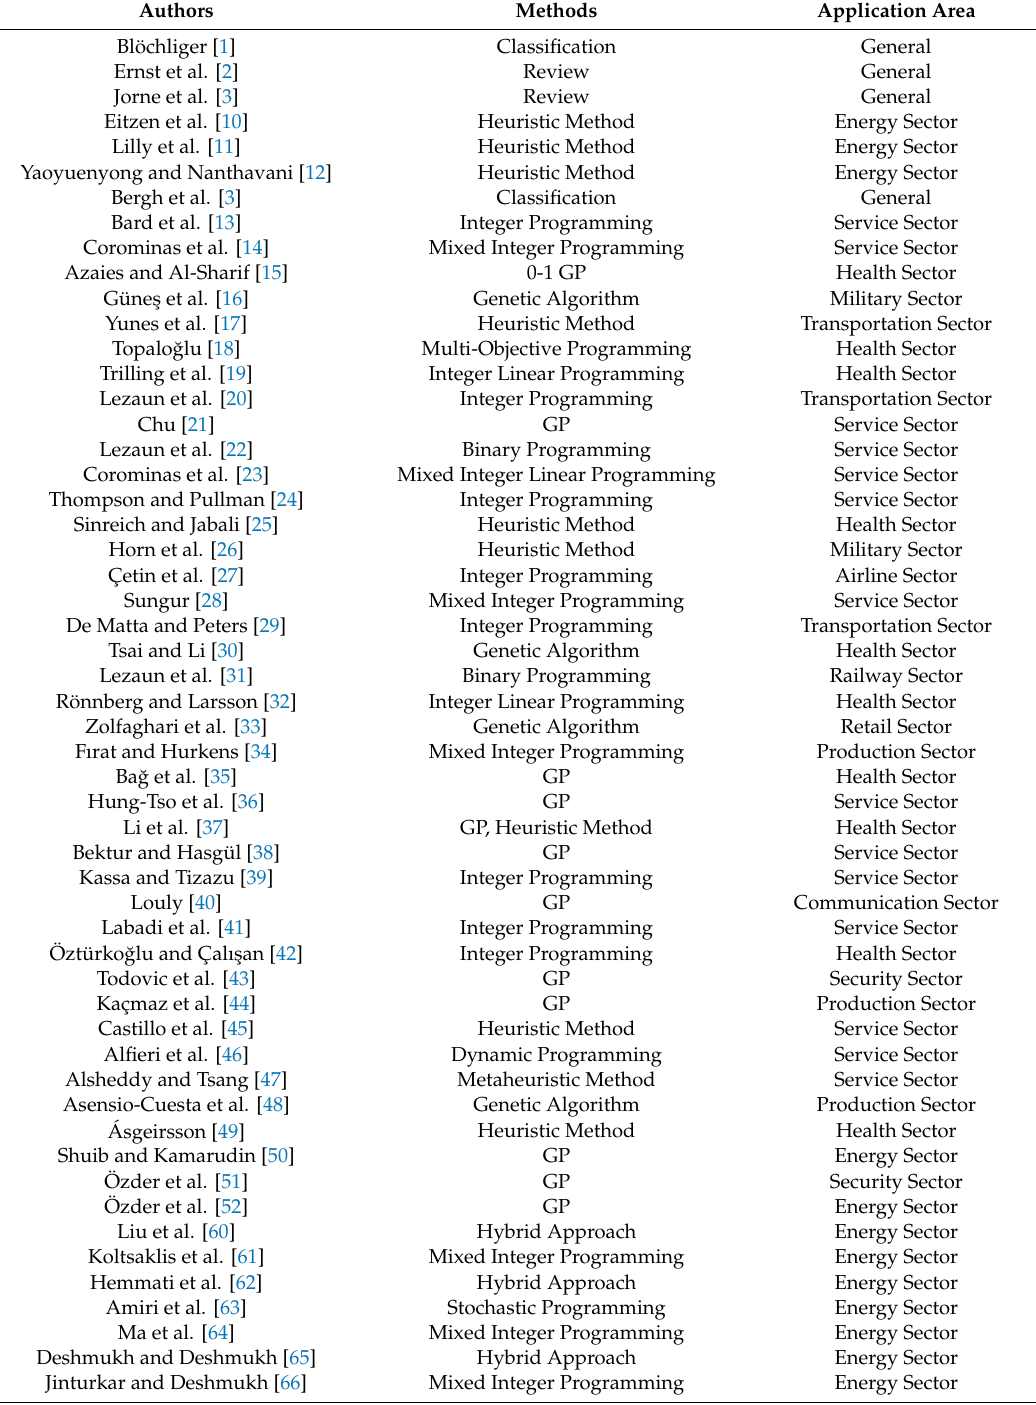
Table 1. Related studies about personnel